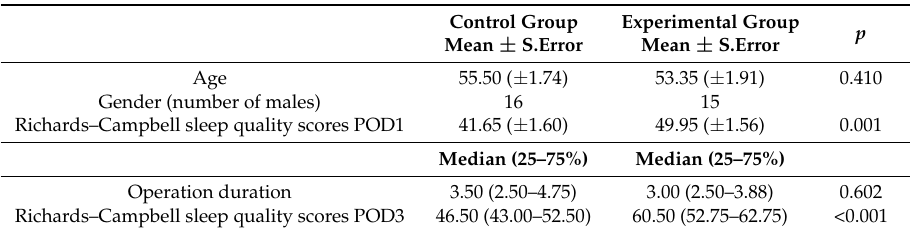
Table 1. Basic patient demographics, duration of surgery, and postoperative Richards–Campbell sleep quality scores.